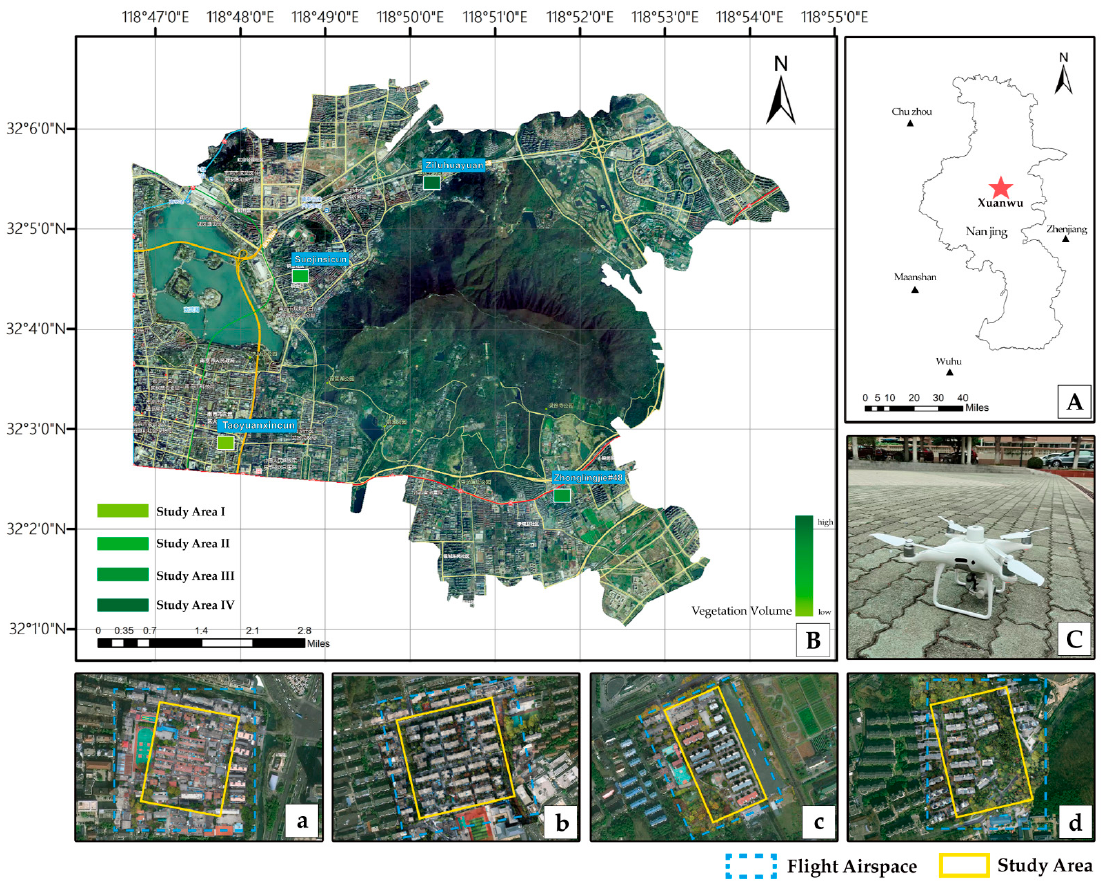
Figure 5. Schematic overview of the site ( A ) and plot location ( B ), as well as the experimental set-up ( C ). Residential communities included four area types. According to the satellite map, there are four communities ( a – d ) with green levels ranging from low to high. The satellite map of Nanjing city was downloaded from Bigmap GIS Office (industry version).